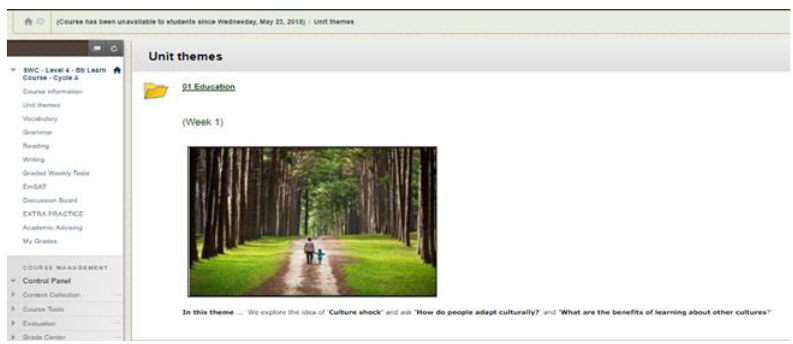
Figure 2: example theme on LMS